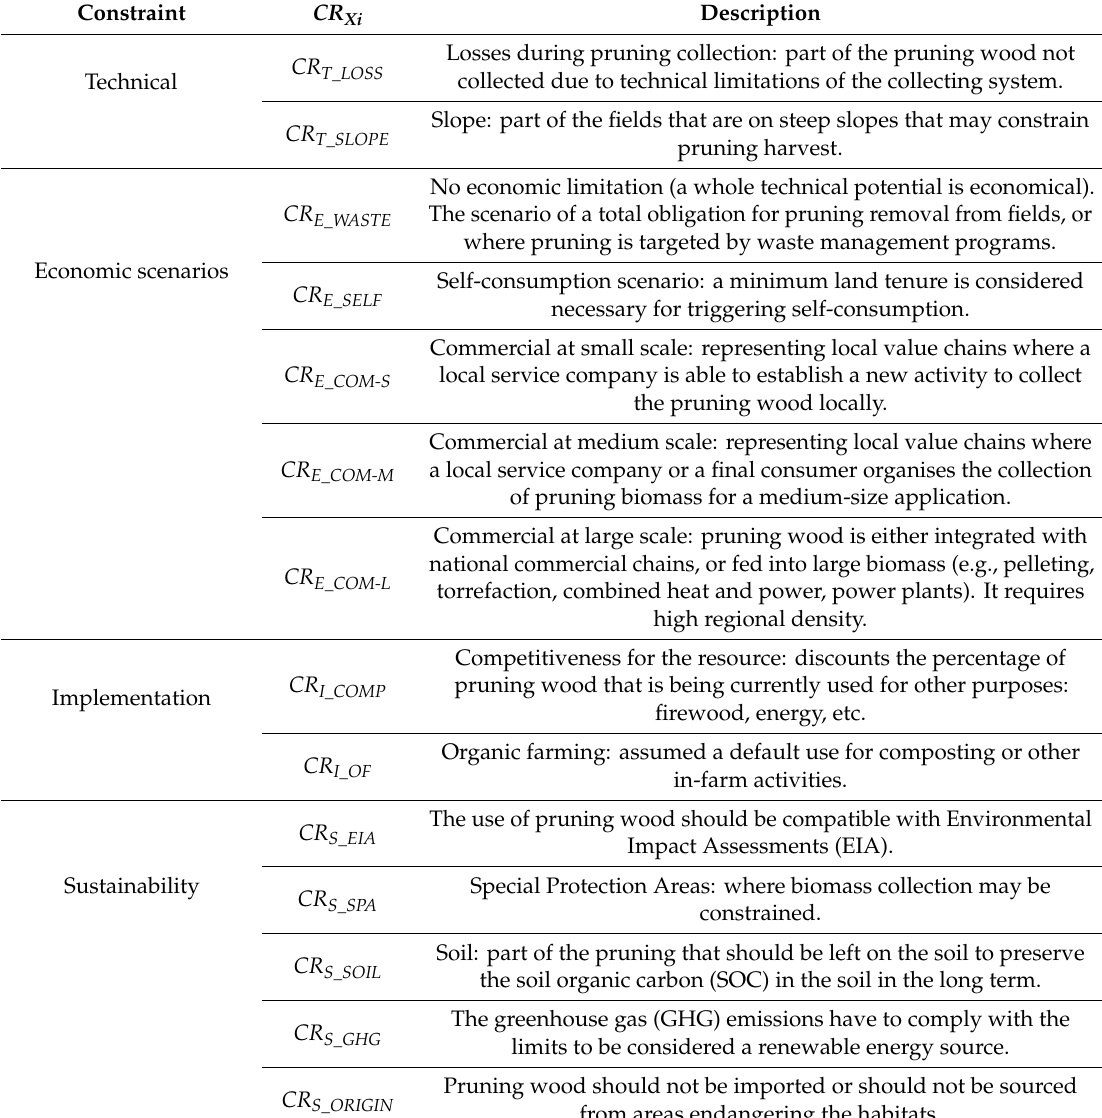
Table 1. Description of the coe ffi cients of reduction and its